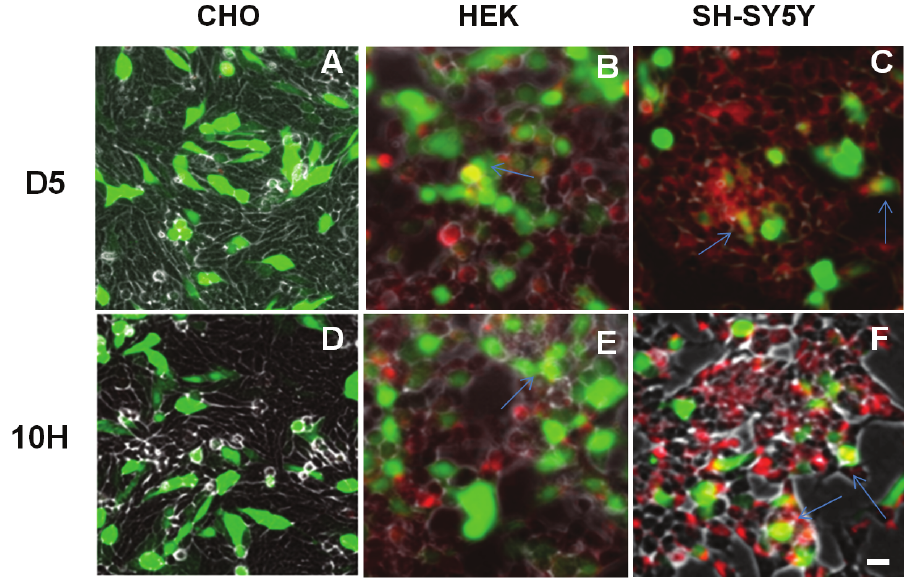
Figure 4. Localization of D5 and 10H reactive (cid:2)-synuclein aggregates in CHO, HEK and SH-SY5Y cells overexpressing (cid:2)-synuclein. Cells were seeded in 6-well plates with a density of 10 5 cells/well and treated with 2:1 transfected reagent and wt-synuclein-EGFP (green). After 72 h, the cells were fixed with formaldehyde and probed without or with D5 or 10H scFv antibody fragments (red). Arrows indicate co-localization. The scale bar equal to 50 μm. We quantified the levels of total (cid:2)-synuclein and the D5, 10H reactive oligomeric (cid:2)-synuclein in the different cell lines expressing both endogenous and overexpressed levels of (cid:2)-synuclein by ELISA (Figure 5). Overexpression of (cid:2)-synuclein in CHO cells did not result in a significant increase in D5